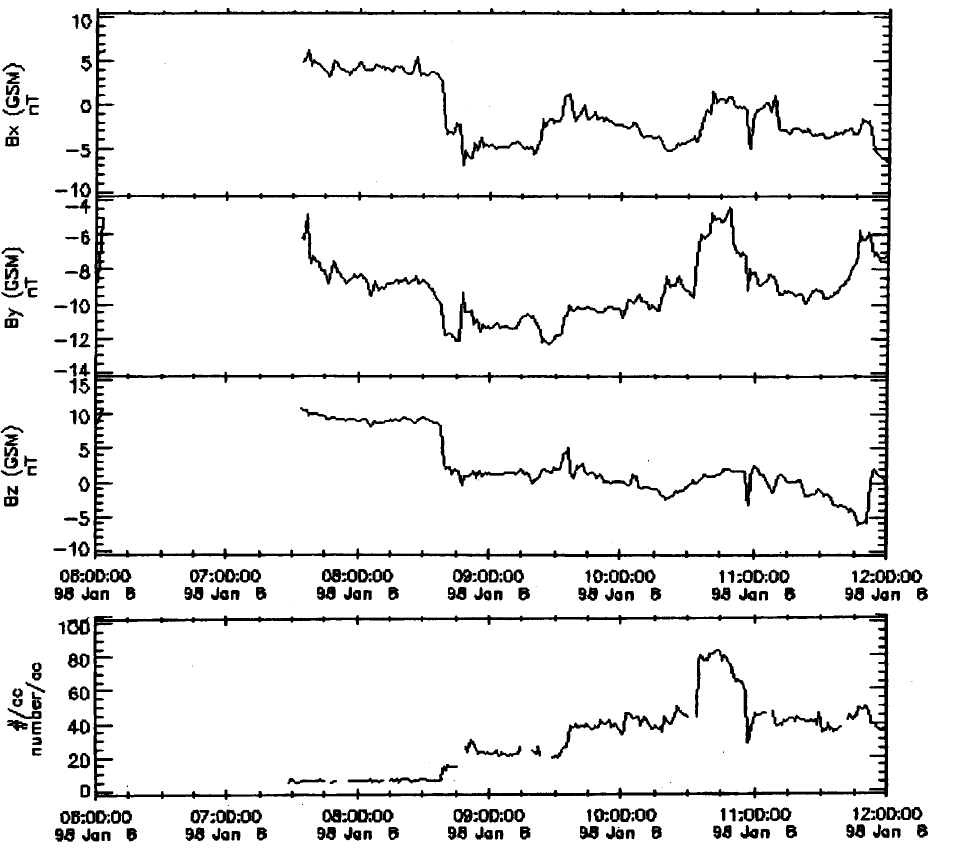
Fig. 1. Key parameter data from IMP-8 showing the three compo- nents of the IMF and the solar